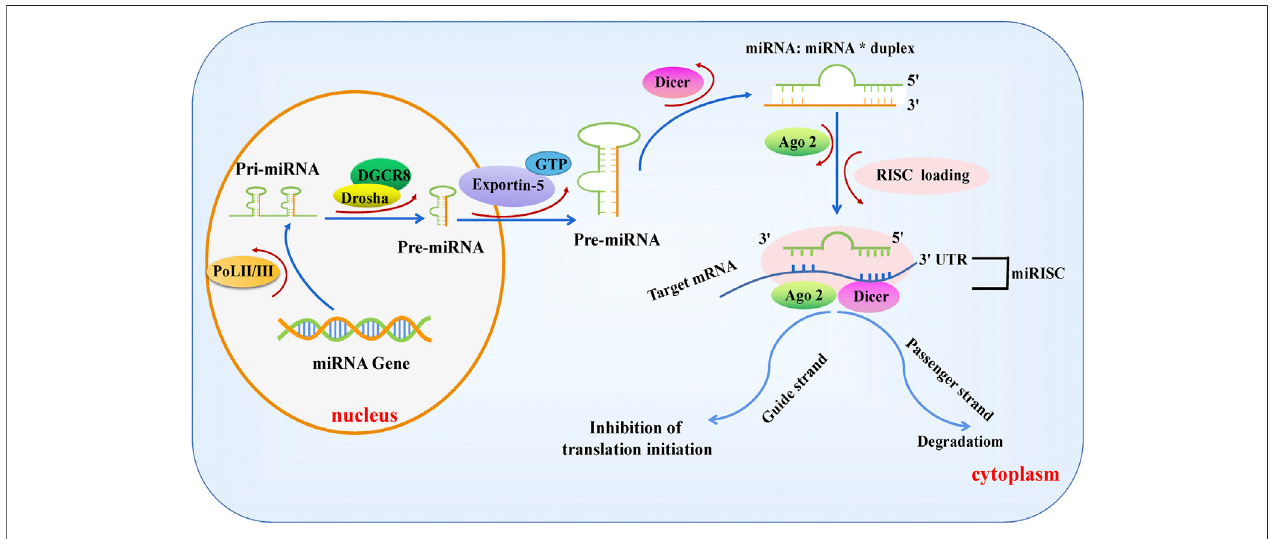
FIGURE 1 | Biogenesis of canonical microRNAs. MiRNA genes are transcribed into a single-stranded primary miRNA by POL II or POL III, followed by the modi fi cation of the stem-loop structure of pri-MiRNAs by DROSHA, resulting in the formation of a 70 – 100 nt pre-miRNA with the assistance of the RNA-binding protein DGCR8. Subsequently, pre-miRNAs are exported to the cytoplasm by Ran GTPase and Exportin-5 and cleaved by Dicer to form mature miRNA double strands, one of which, known as the guide strand, is introduced into the RISC complex containing AGO. The other strand, called the passenger chain, is degraded. The miRNA- loadedRISCcombineswiththereversecomplementarysequencewithinthe3 ′ UTRofthetargetmRNA,suppressing thetranslationordegradation